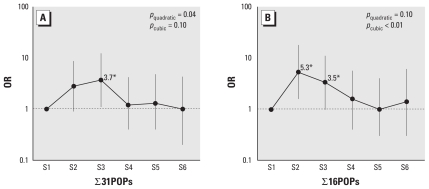
Adjusted ORs and 95% CIs of incident diabetes according to sextiles of the summary measure formed from serum concentrations of all 31 POPs (∑31POPs; A) or 16 selected POPs [∑16POPs; B) (trans-nonachlor + oxychlordane + mirex + PBB153 + 12 PCBs) with ORs ≥ 1.5 in the second quartile in Tables 3 and 4. Lipid-adjusted model, that is, adjusted for age, sex, race, BMI, triglycerides, and total cholesterol at year 2.*Significantly different from 1, p < 0.05.